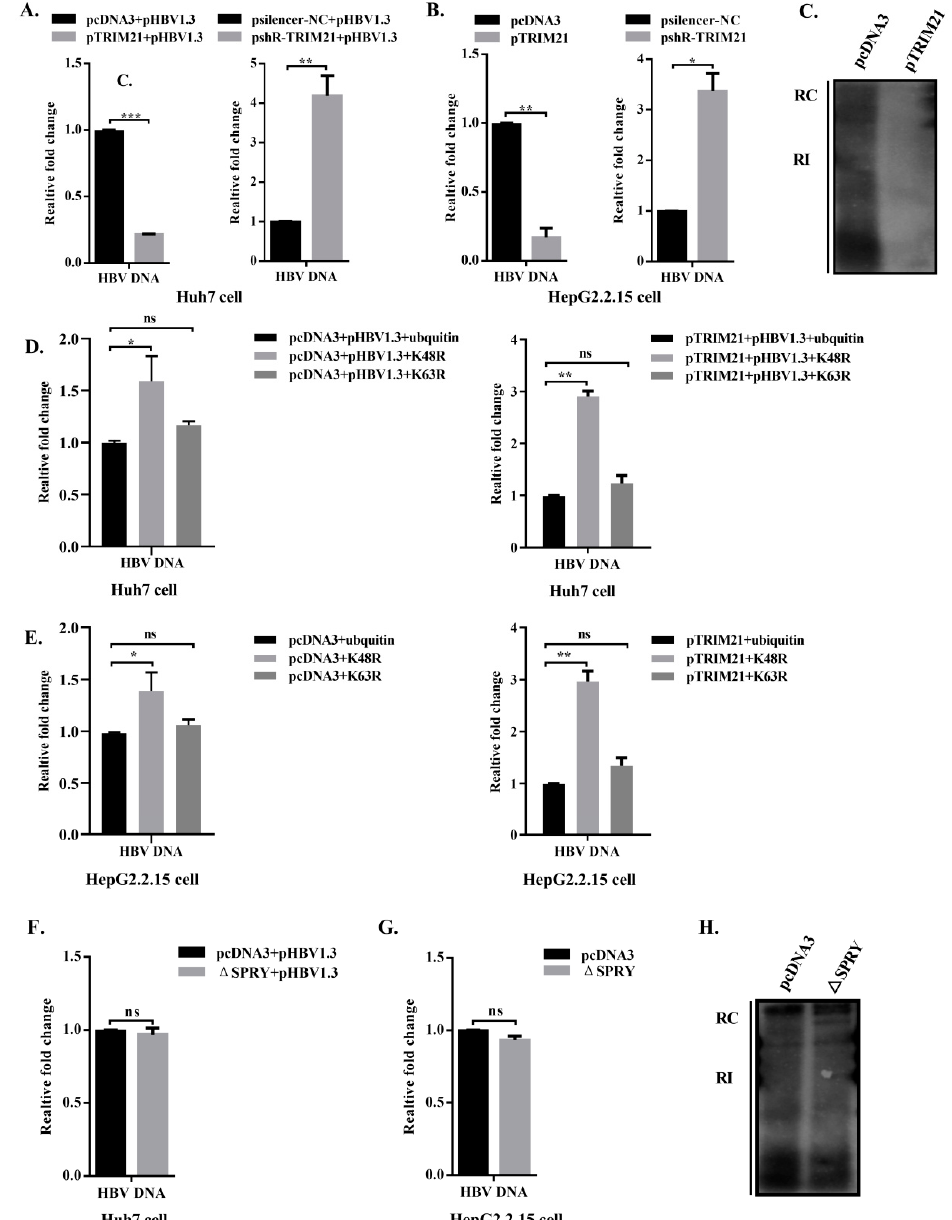
Figure 6. TRIM21 restricts HBV DNA replication. ( A ) Huh7 cells were cotransfected with pHBV1.3 and pcDNA3 or TRIM21 plasmid or pSilencer-NC or shR-TRIM21. qPCR was used to detect HBV DNA. ( B ) HepG2.2.15 cells were transfected with pcDNA3, TRIM21, pSilencer-NC or shR-TRIM21. HBV DNA was detected as described in ( A ). ( C ) HepG2.2.15 cells were transfected with pcDNA3 or TRIM21, and Southern blot was used to detect the cellular replicative intermediate DNA (RI-DNA). ( D ) Huh7 cells were transfected with pHBV1.3, pcDNA3 (left panel) or pTRIM21 (right panel) and ubiquitin or K48R or K63R. HBV DNA was detected by qPCR. ( E ) Except for pHBV1.3, HepG2.2.15 cells were transfected as described in ( D ), and the relative levels of HBV DNA were detected in HepG2.2.15 cells. ( F ) Huh7 cells were cotransfected with pHBV1.3 and pcDNA3 or TRIM21- ∆ SPRY, and the HBV DNA level was detected by qPCR. ( G ) Except for pHBV1.3, HepG2.2.15 cells were transfected as described in ( F ). ( H ) HepG2.2.15 cells were transfected with pcDNA3 or TRIM21- ∆ SPRY, and RI-DNA was examined by Southern blot. Data are representative of three independent experiments with three replicates each. The data represent the means ± S.D. * P < 0.05, ** P < 0.01, *** P <